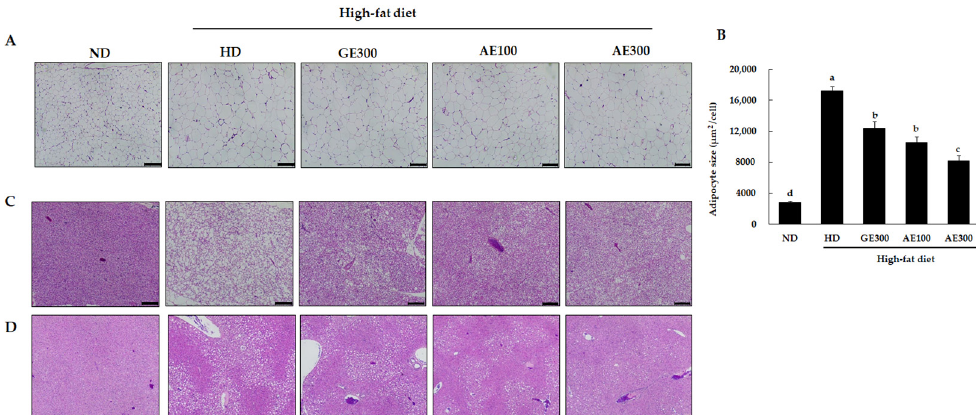
Figure 3. Effect of AE on epididymal white adipose tissue (eWAT), brown adipose tissue (BAT), and liver in the experimental mice, observed by H&E staining. Mice were fed as previously indicated. ( A ) eWAT, ( B ) adipocyte size, ( C ) BAT, and ( D ) liver. Scale bar = 200 μ m. ND, normal diet, HD, high-fat diet, GE300, high-fat diet + Garcinia 300 mg/kg b.w, AE100, high-fat diet + 100 mg/kg b.w, AE300, high-fat diet + 300 mg/kg b.w. Values are expressed as mean ± SEM, n = 10. The varying superscript letters indicate a statistically significant difference among the groups by Duncan’s test of ANOVA, p < 0.05.